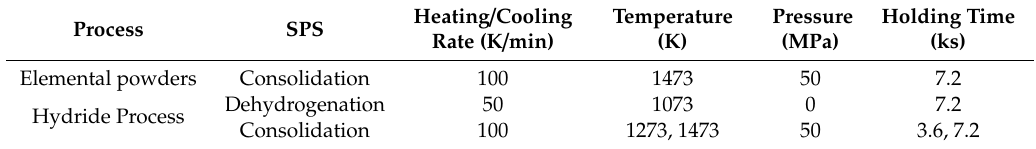
Table 3. Different dehydrogenation and / or sintering conditions of the spark plasma sintering (SPS)